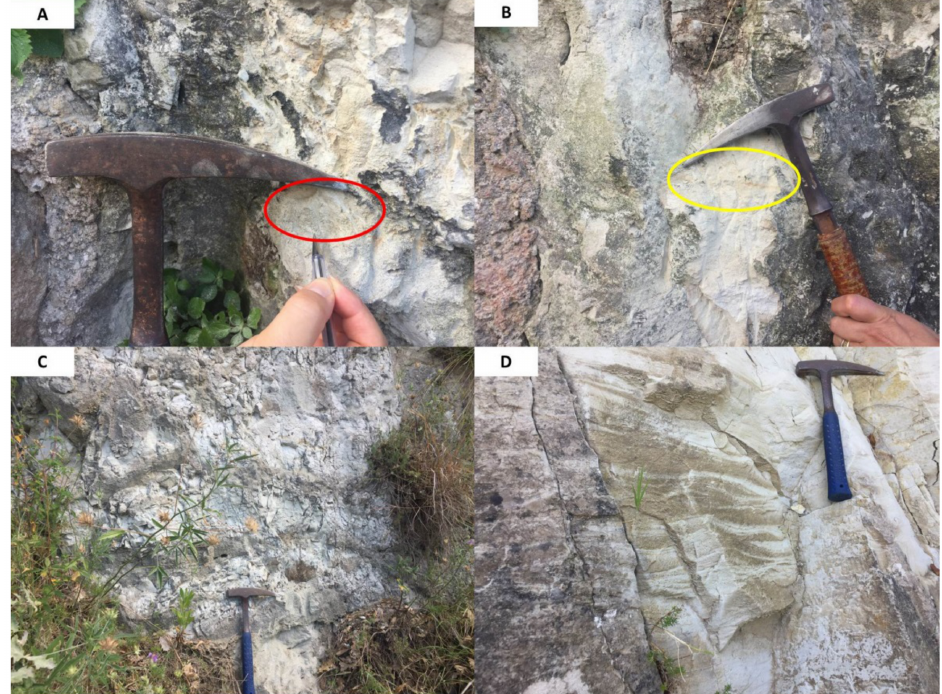
Figure 5. Volcaniclastic interval on the field: ( A ) red circle: interbedded coarser layers of predomi- nant siliciclastic composition (BE-20-02); ( B ) yellow circle: oxidized interbedded coarser layers of predominant siliciclastic composition (BE-20-03); ( C ) rhythmic alternating coarse and fine beds of the volcaniclastic interval in Belmonte outcrops; ( D ) S. Caterina outcrop (SC-20-05,